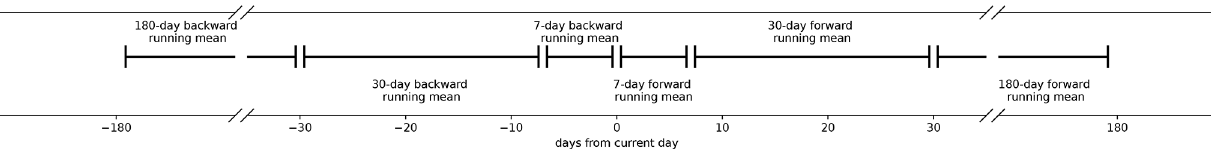
Figure 3. Time lags and window sizes of embedded features used in this study. stopped (stopping criterion, Algorithm 1, second loop, lines 5 to 15) once the change in the estimates for the missing val- ues is small between iterations (convergence) or a maximum number of iterations is reached (early stopping).